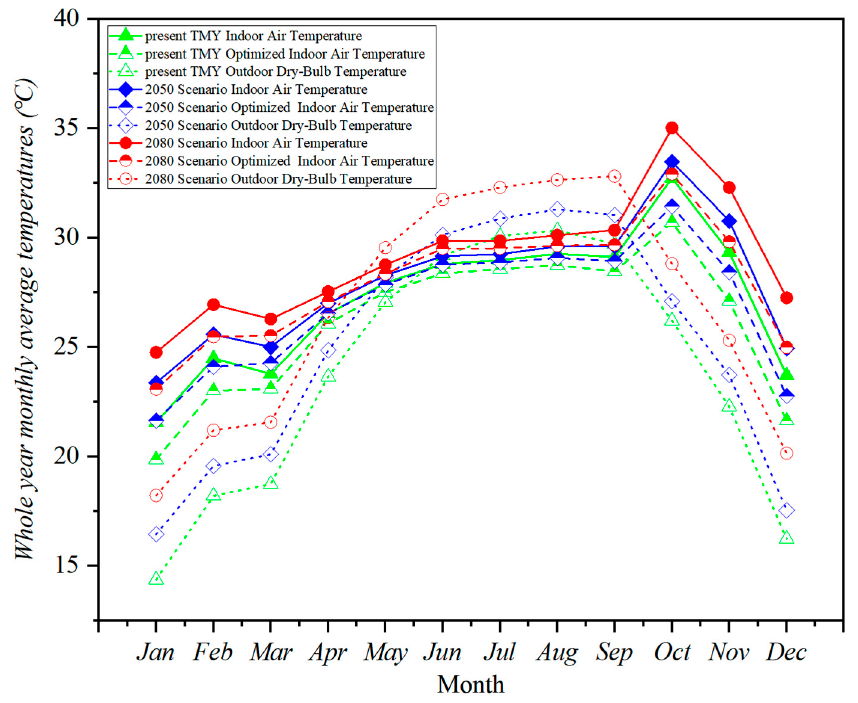
Figure 18. Whole year monthly average temperatures of baseline and optimized prototypes upon present TMY and predicted future scenarios (2050 and 2080).